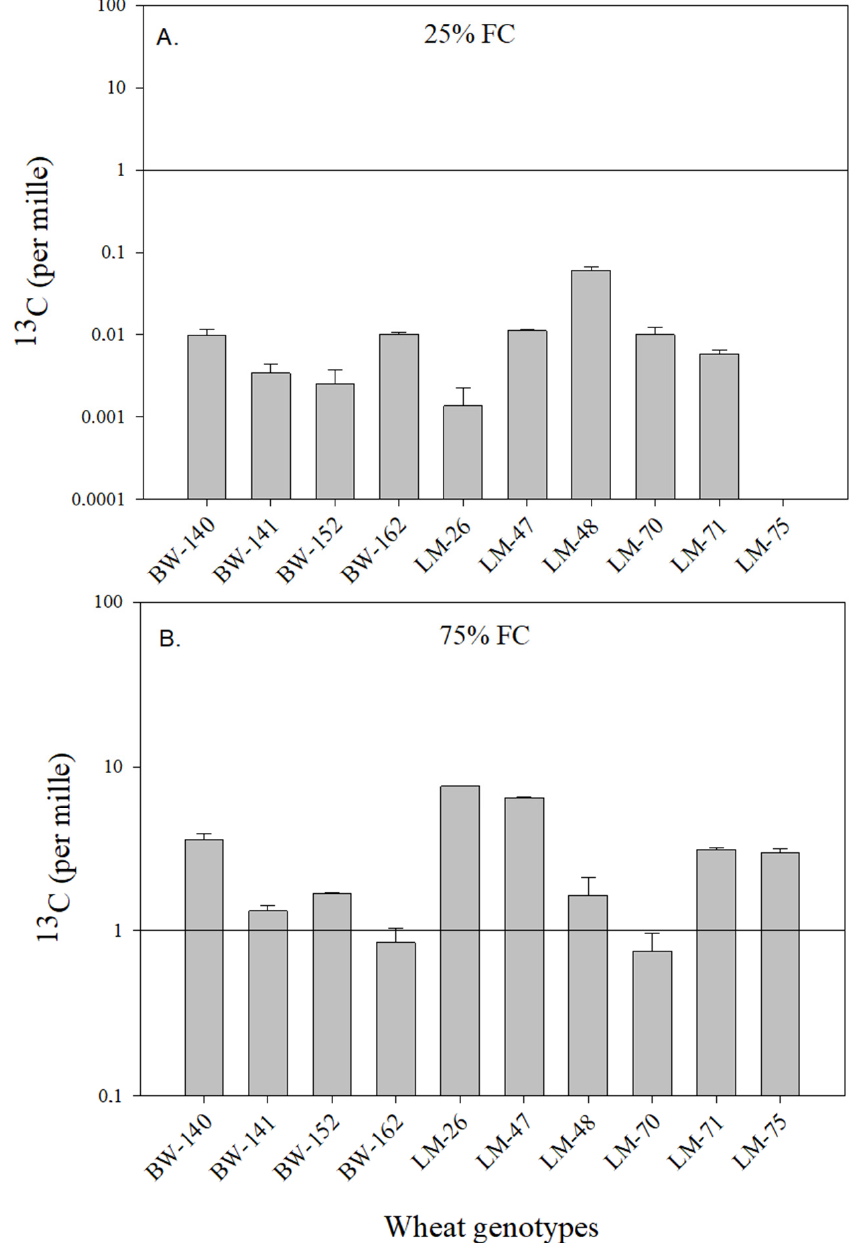
Figure 6. Excess 13 C content in the soil after harvest as compared to before pulse labeling for drought ( A ) and well-watered ( B ) treatments and for the studied wheat genotypes. Data are mean and standard errors (n = 3).